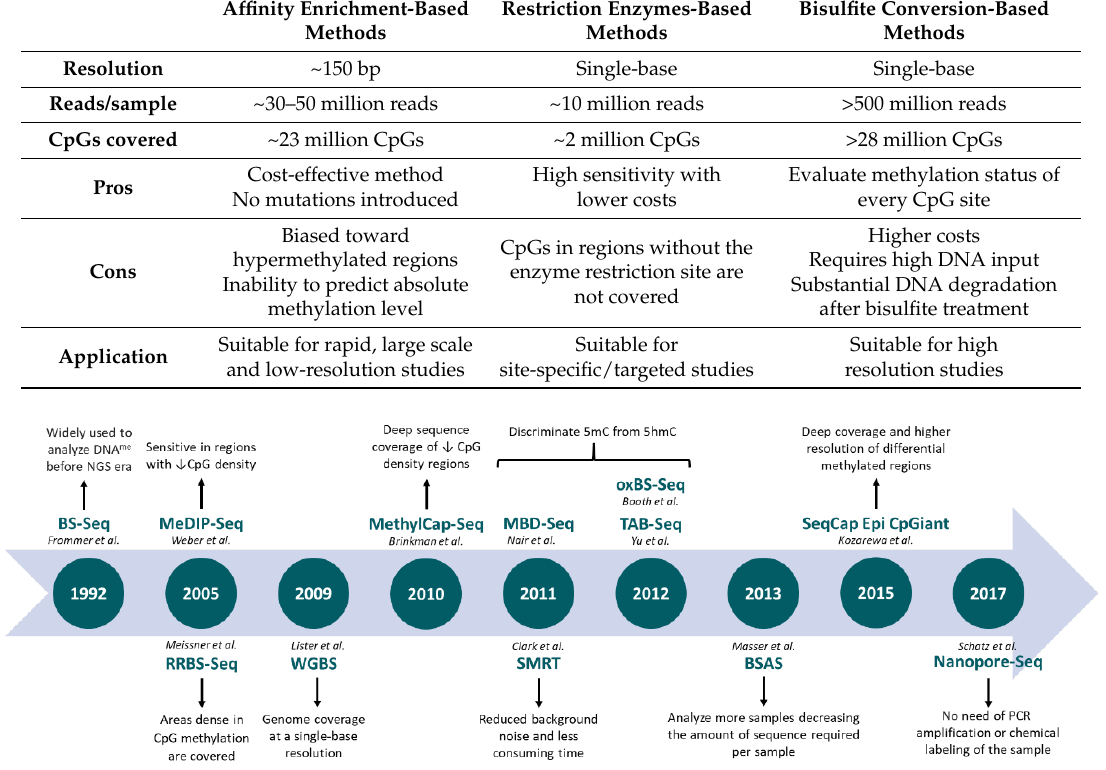
Figure 1. Evolution of next-generation sequencing-based techniques applied to DNA methylation profiling. BS-Seq: bisulfite sequencing; MeDIP-Seq: methylated DNA immunoprecipitation